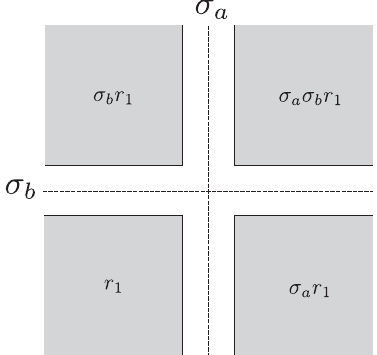
FIG. 9. Cross section of a 3D system with C 2 v symmetry, which is generated by the two mirror reflections σ a and σ b . The dashed lines are mirror planes. The shaded regions can be trivialized by applying a symmetry-preserving local unitary, reducing the system to the cross-shaped region near the mirror